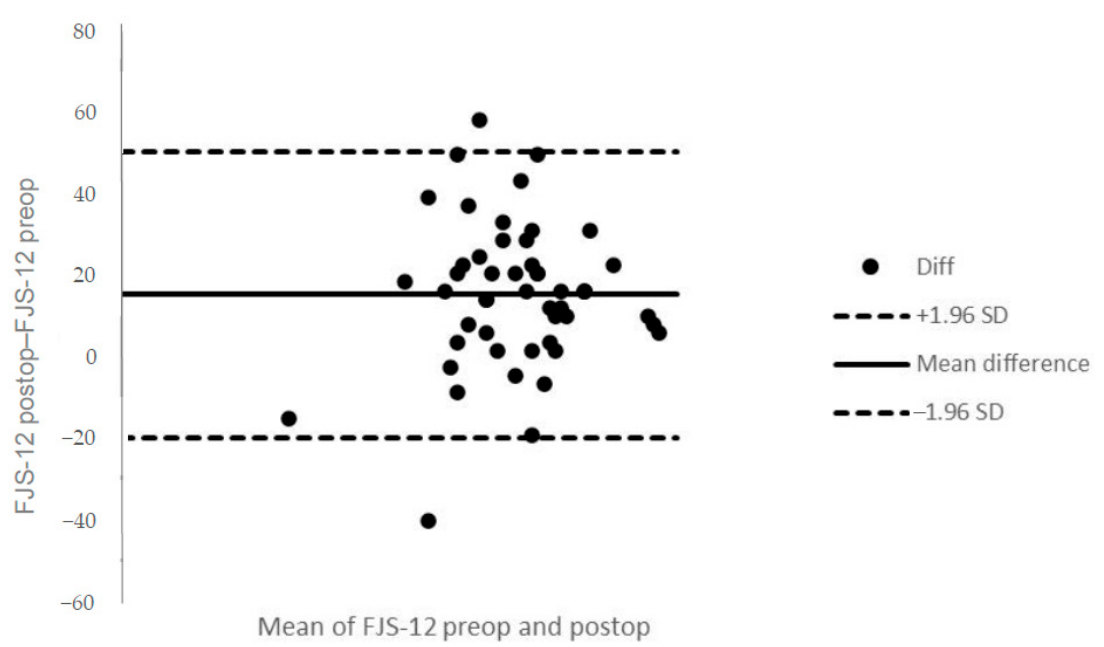
Figure 1. Bland-Altman plot for the mean differences of Forgotten Joint Score 12 (FJS-12) between pre-operative and postoperative follow-up. The mean difference is indicated by the solid horizontal line, and the limits of agreement are demarcated by the dashed horizontal lines.